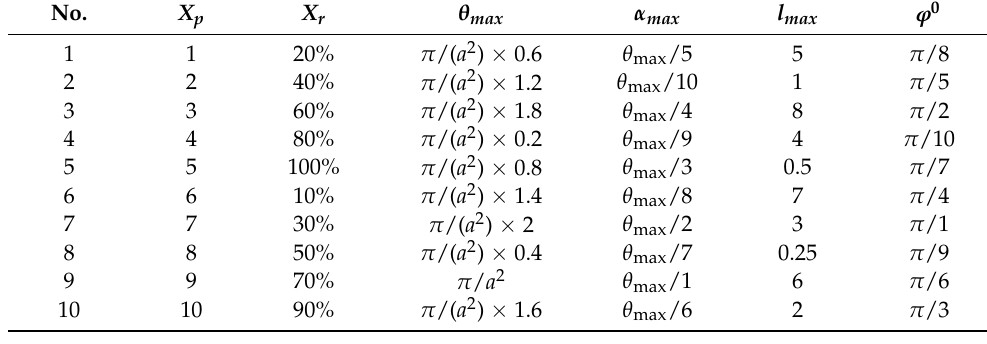
Table 9. Example of crossover performed using L 8 (2 7 ) for X p 1 and X p 2 with 5 dimensions. No.